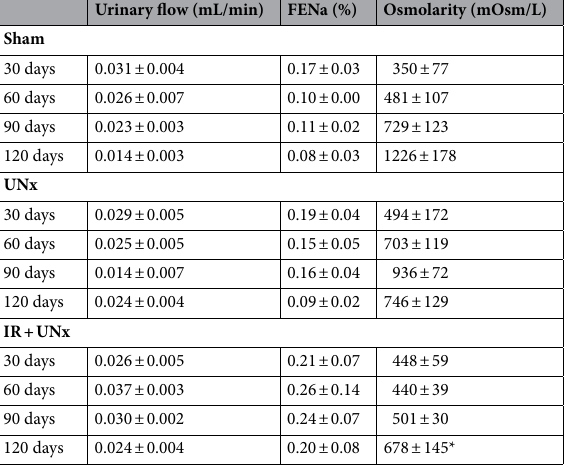
Table 1. Urine Chemistries along the study for all the included groups. * p < 0.05 versus respective